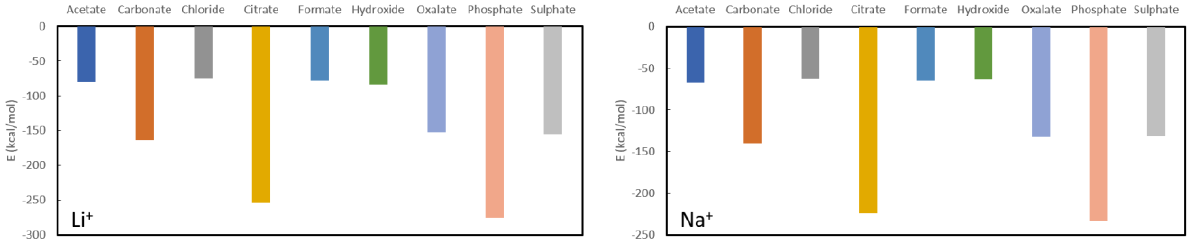
and 40 kcal/mol more stable than for sodium. Both lithium and sodium are expected to be good phosphate binders (complexation energies of −274.8 kcal/mol and −233.8 kcal/mol) and reasonable oxalate binders ( −152.5 kcal/mol and −132.6 kcal/mol) when appropriate ligands are used for administration. More specifically, the use of citrate ( −254.3 kcal/mol and −224.3 kcal/mol) is to be avoided for phosphate binding, while citrate, sulphate ( −155.2 kcal/mol and −13 1.7 kcal/mol) and carbonate ( −163.5 kcal/mol and −139.8 kcal/mol) are to be avoided for oxalate binding. The remaining ligands have complexation energies with respectively lithium and sodium of −80.7 kcal/mol and −66.9 kcal/mol for acetate, −75.0 kcal/mol and −62.7 kcal/mol for chloride, −79.0 kcal/mol and −64 .9 kcal/mol for formate and −84.2 kcal/mol and −63.8 kcal/mol for hydroxide.